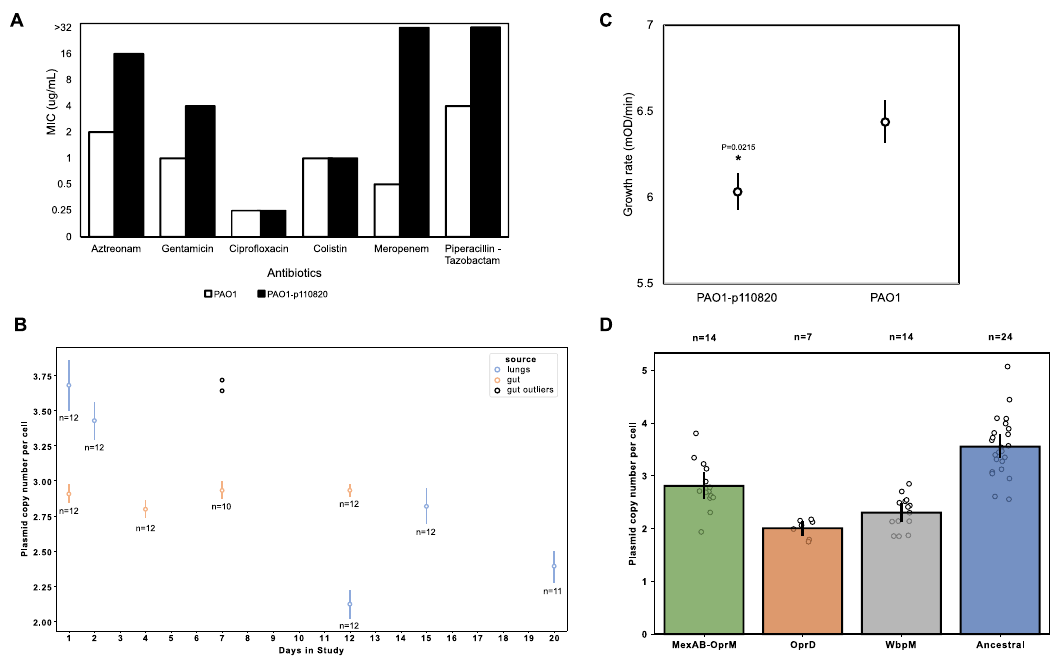
Fig. 4 Plasmid-encoded resistance. A Antibiotic resistance phenotypes of PA01:p110820 transformants compared to a plasmid-free PA01 control. Plasmid carriage increased resistance to meropenem and piperacillin-tazobactam to at least 32 mg/L, exceeding the EUCAST clinical breakpoints (meropenem, 8 mg/L; piperacillin-tazobactam, 16 mg/L). B Changes in plasmid copy number during infection. Plotted points show the mean plasmid copy number of lung (blue) and gut (beige) isolates from each time point ( + / − s.e.m.; n = 10 – 12 isolates), excluding two genetically divergent gut isolates that are